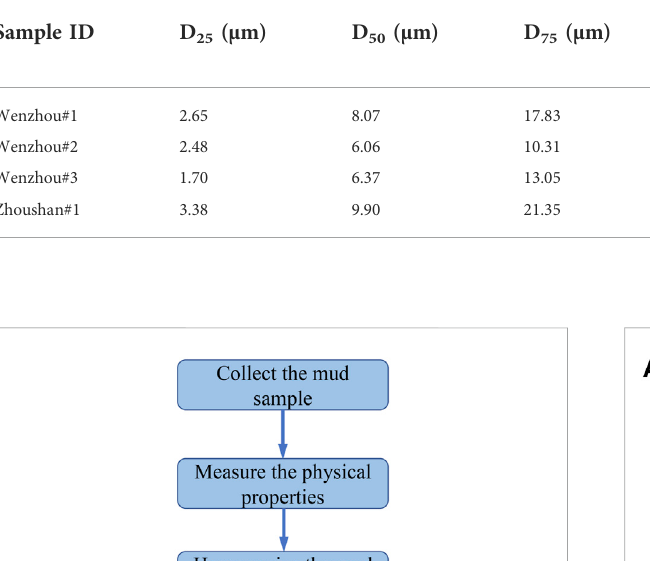
TABLE 1 Characters of the mud samples.